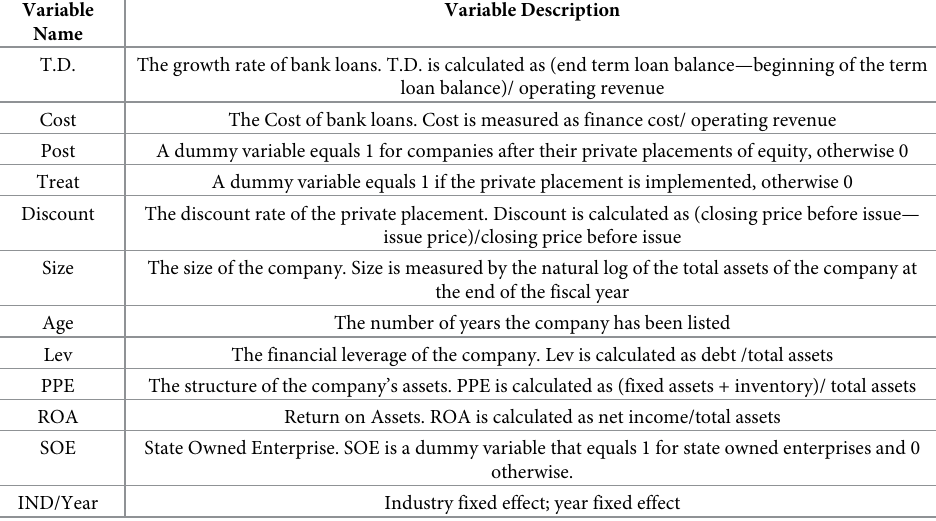
separate the full sample into two subsamples, with and without institutional investors, to test H3. Controls represent the control variables in this study. Referring to the literature on corpo- rate bank loans (e.g., [37,38], we include control variables such as Size, Age, Asset Structure ( PPE ), Leverage ratio ( Lev ), and Profitability ( ROA ) in the model. Table 1 summarizes the names and descriptions of the variables.